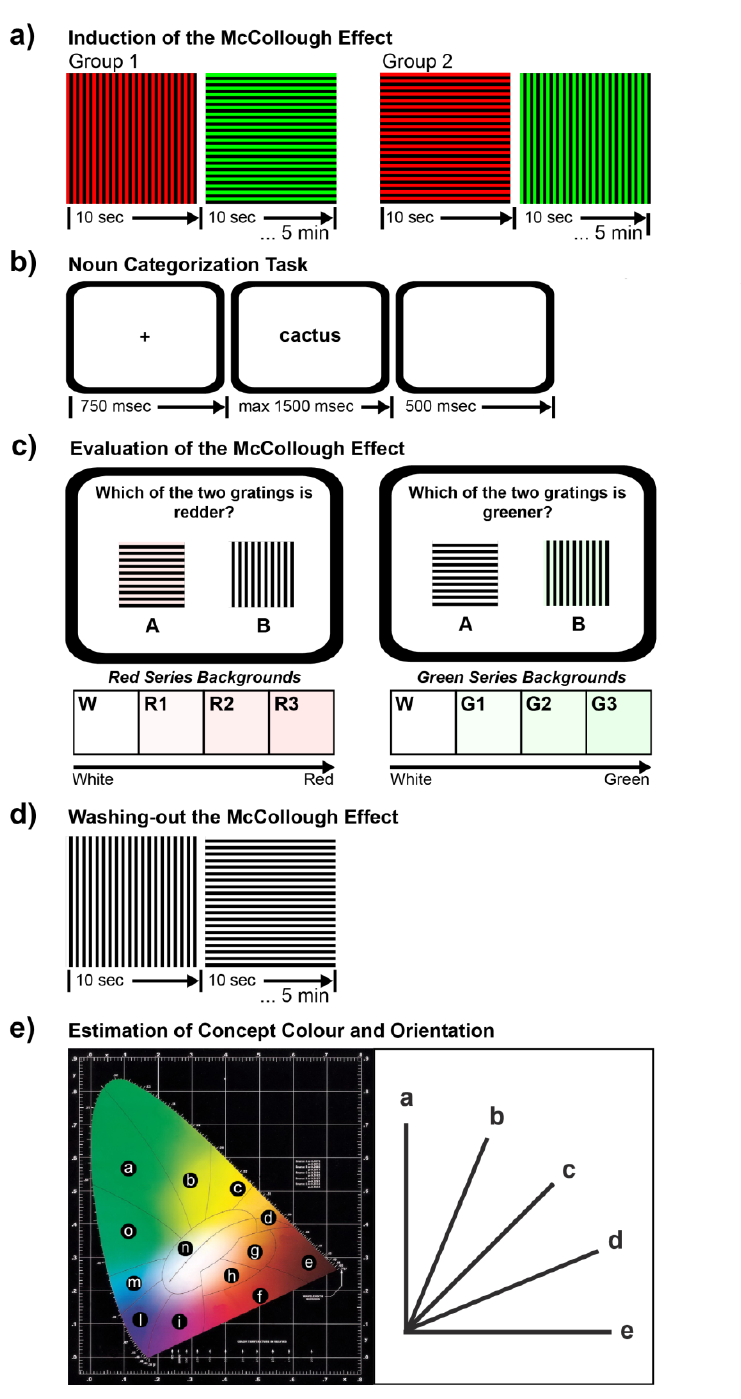
Figure 1. Experimental procedure and materials. ( a ) Orthogonally oriented grating patterns used for each group of subjects to induce a McCollough effect of inverse polarity, and timing of stimulus presentation; ( b ) Schematic diagram of trial structure for the noun categorization task; ( c ) Sample of grating pairs for comparisons and color palettes for backgrounds of the red and the green series; ( d ) Achromatic oriented grating patterns used for deleting the McCollough effect; ( e ) Left: the CIE (Comission Internationale de l'Éclairage) color space chromaticity diagram used for the estimation of concept color and its division into regions of different color. Right: diagram used for the estimation of concept